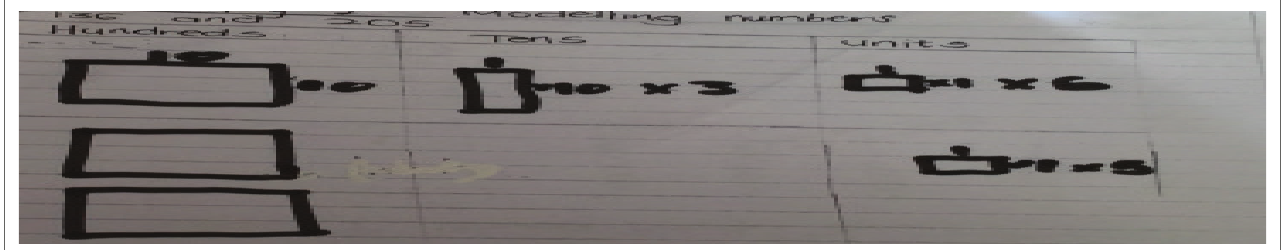
FIGURE 10: (a & b) Sample of students’ response to item 9.